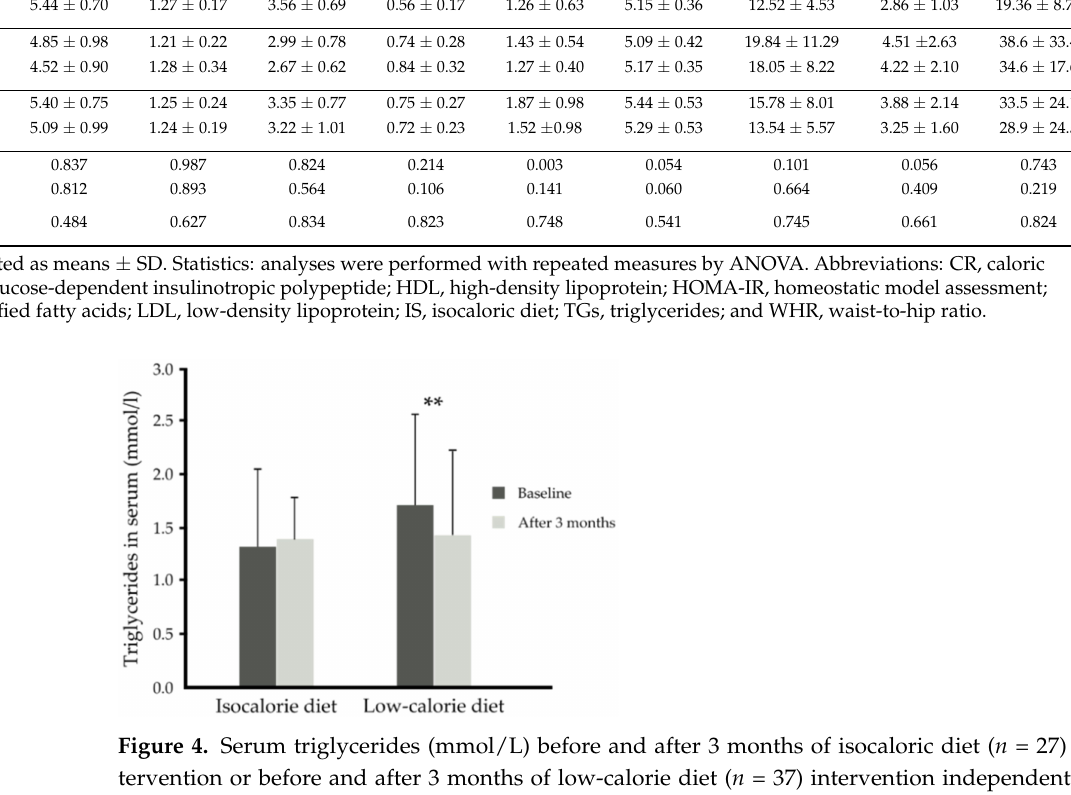
Table 3. Serum lipids and glucose metabolism parameters before and after 3 month dietary intervention in obese subjects. Group Time IS + placebo ( n = 14)